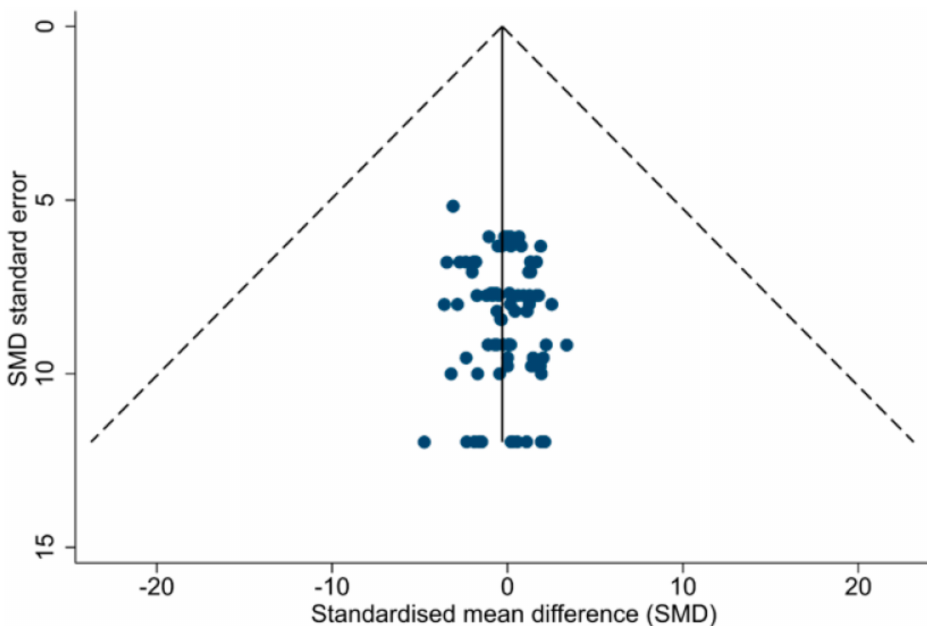
Figure 4. Funnel plot of Standardized Mean Difference (SMD) and SMD standard error with pseudo 95% CI limits for all study measurements, showing no significant asymmetry, which suggests low risk of publication bias. Eggert test p value is